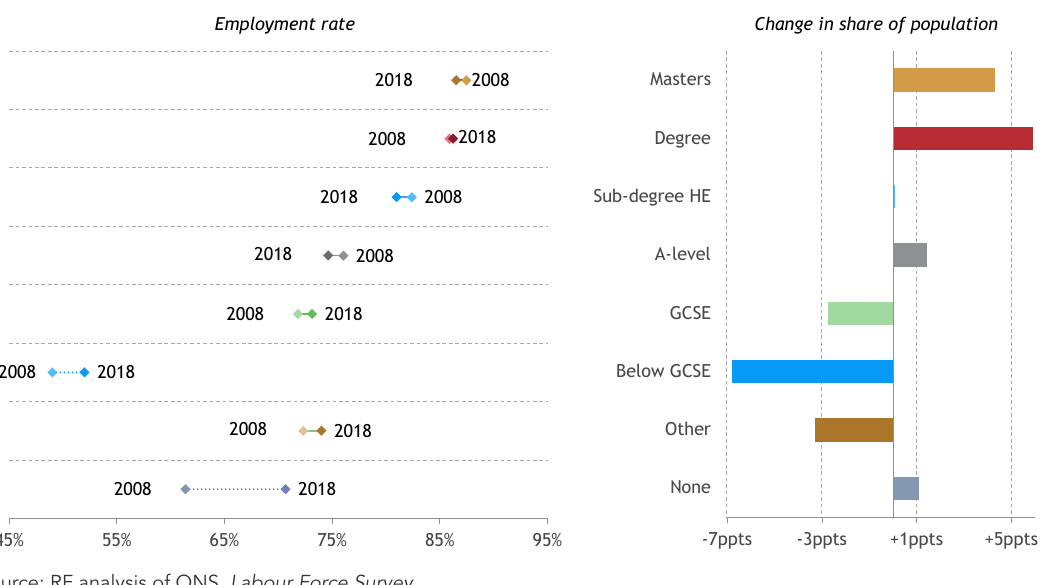
Figure 10: There has been a notable increase in the proportion of the population with a degree Employment and population changes by qualification, 16-64 year olds: